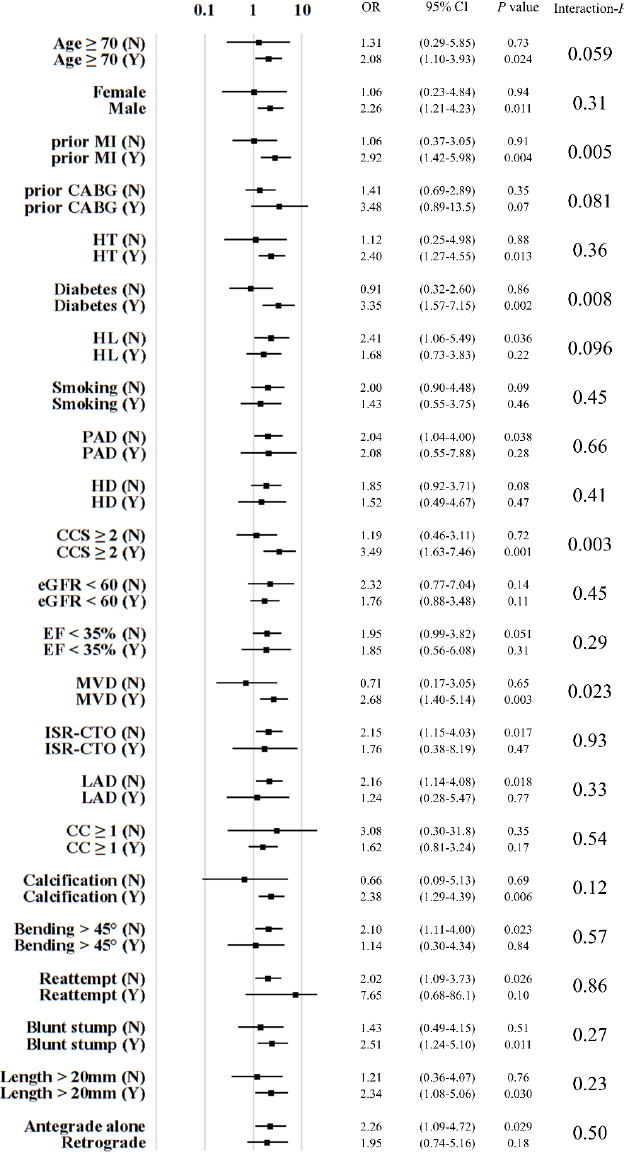
Figure 2. Stratified analysis of odds ratios for procedural results of CTO-PCI and one-year mortality in the two-way analysis of variance. Abbreviations: CABG, coronary artery bypass grafting; CC, collateral connection; CCS, Canadian Cardiovascular Society; CI, confidence interval; eGFR, estimated glomerular filtration rate; EF, ejection fraction; HD, hemodialysis; HL, hyperlipidemia; HT, hypertension; ISR, in-stent restenosis; LAD, left anterior descending artery; MI, myocardial infarction; MVD, multivessel disease; OR, odds ratio; PAD, peripheral artery